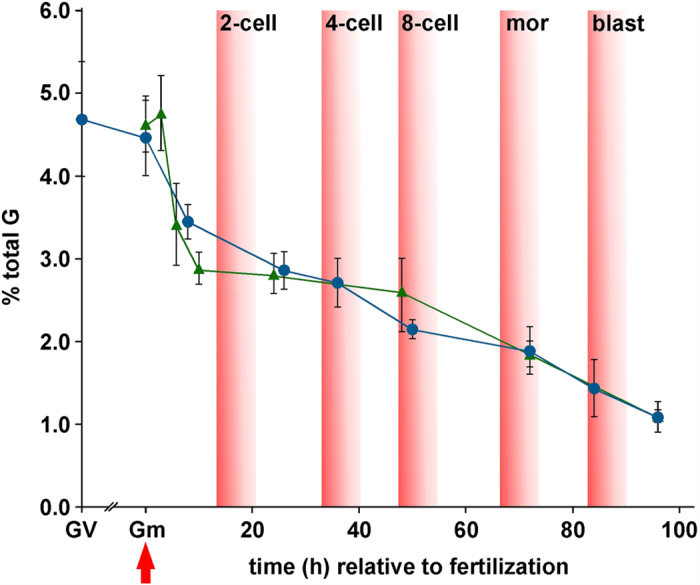
Quantification by SMM of 5 mC during mouse preimplantation development.Germinal vesicle (GV) oocyte and preimplantation embryo 5 mC content (Y-axis) are plotted against the approximate time (h) after fertilization (red arrow). Cell numbers in early (~84 h) and late (~96 h) blastocysts were 32.4 ± 4.23 (n = 12) and 63.7 ± 13.0 (n = 11) respectively. Values are for embryos produced by natural mating (blue circles) and IVF (green triangles). Zero hour values are shown for gametes (Gm) either for mII oocytes (blue circle) or an average of sperm plus mII oocyte (green triangle). Approximate times at which different developmental stages appear are also indicated. mor, morula; blast, blastocyst. Mean values are ±sd (3 ≤ n ≤ 15). Embryo numbers per analysis are given in Supplementary Table S1.